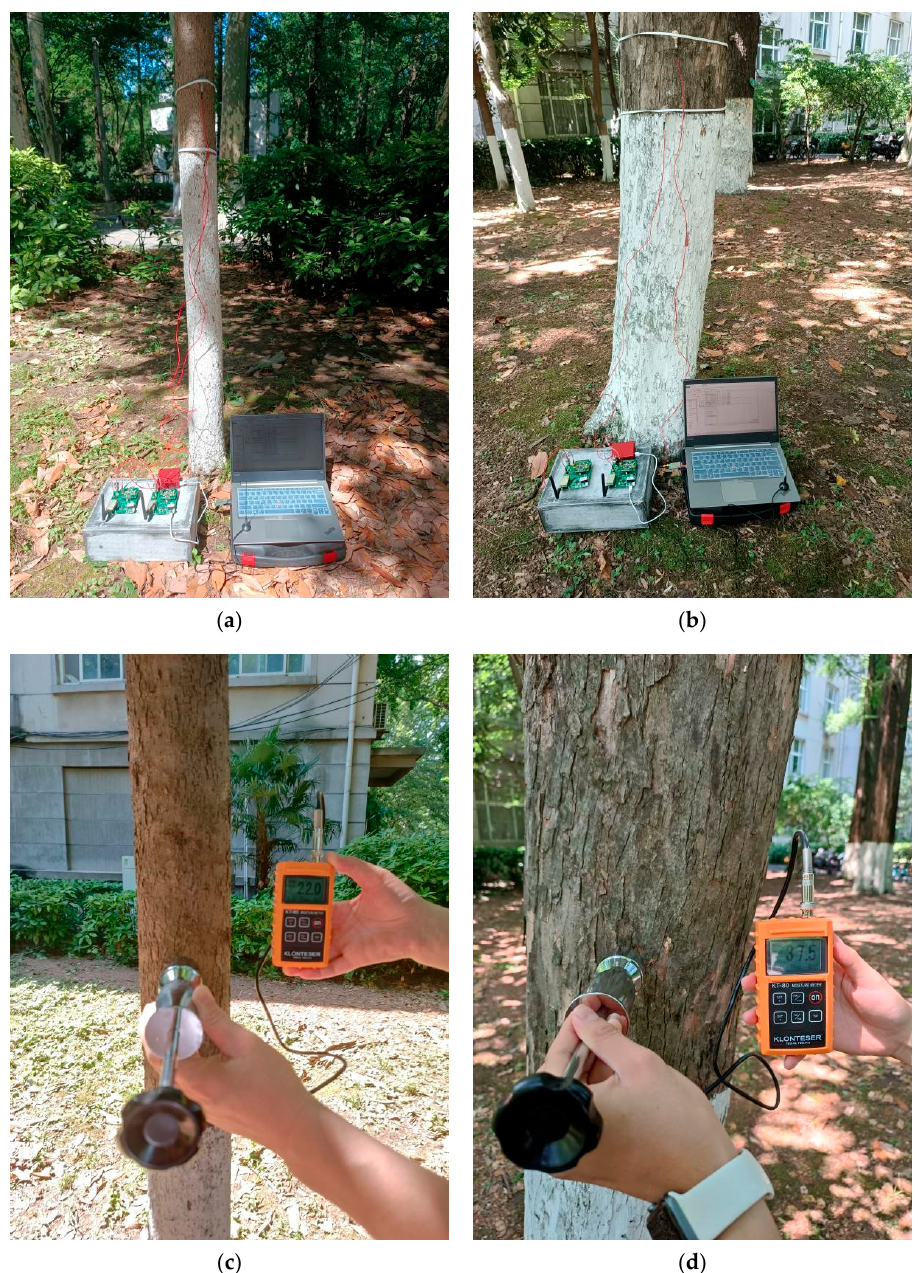
Figure 22. Installation test chart and calibration chart of Zhejiang Nan and Triangle Maple. ( a ) Actual test of this WASN on Zhejiang Nan; ( b ) Actual test of this WASN on Triangle Maple; ( c ) Zhejiang Nan test moisture content calibration chart; ( d ) Triangle Maple test moisture content calibration chart.